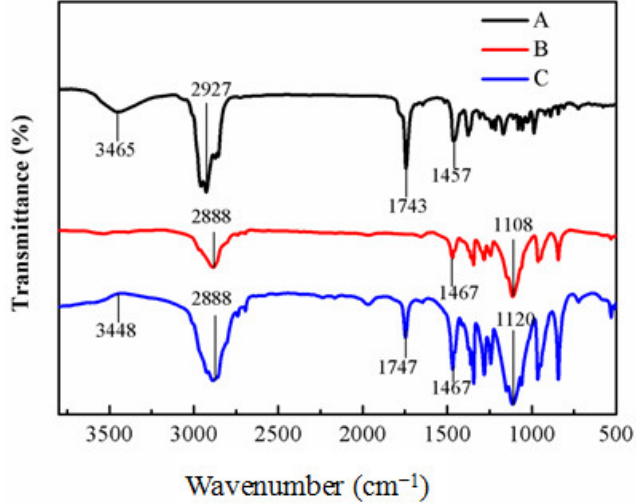
Figure 4. FTIR spectra of QEO ( A ), PF108 hydrogels ( B ), and QEO nanohydrogels ( C